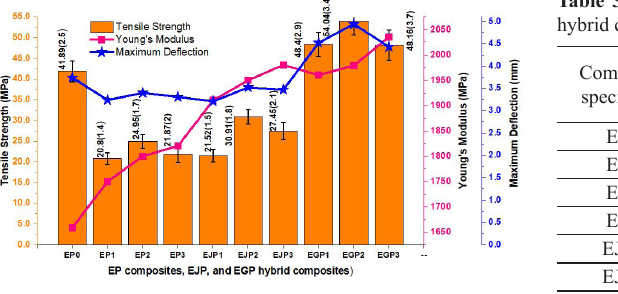
Figure 2. Tensile characteristics of Epoxy, EP composites, and their hybrid composites.